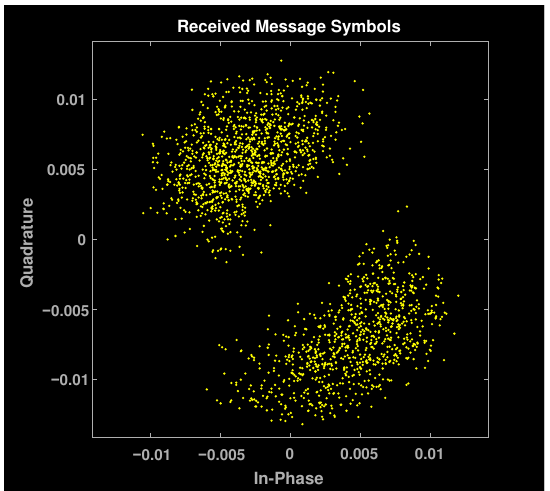
Figure 18. Received message symbols after CFO correction.